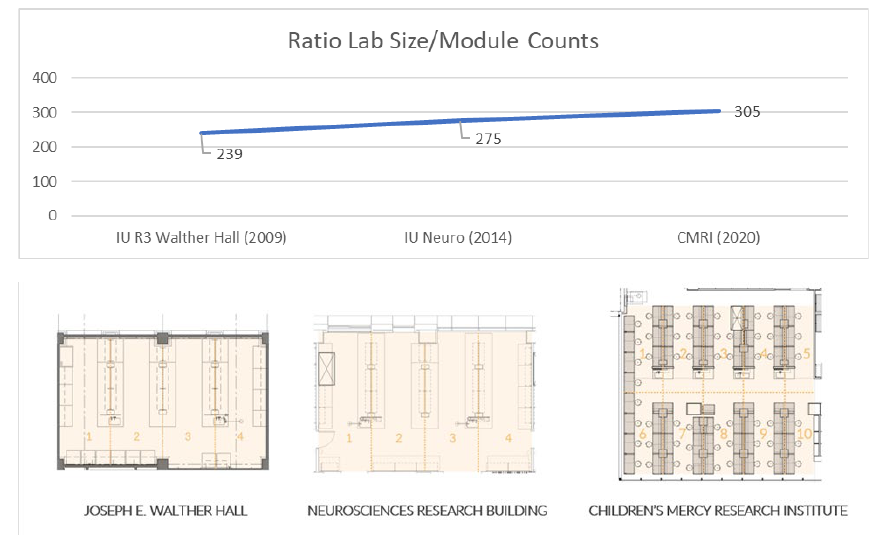
Figure 12 The average ratio of lab size to module counts per project.